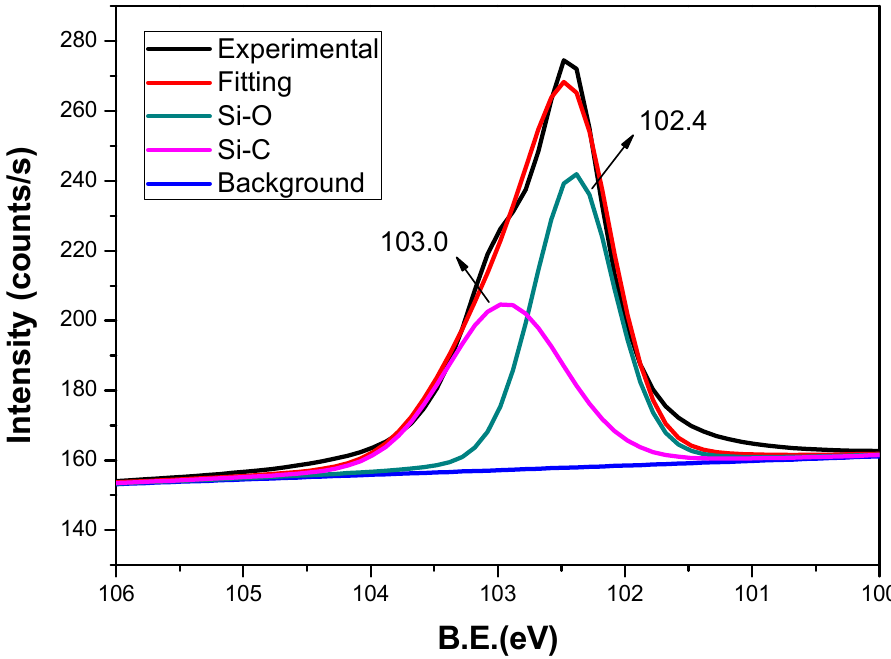
Figure 5. Si 2p XPS spectra for the surface of SPEKEBI-2.5-SiO 2 membrane.